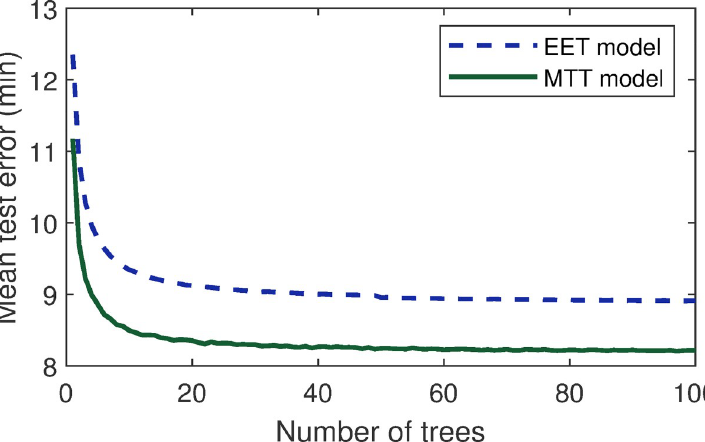
Fig 5. Random Forest regression (RFr) method performance with the estimated elapsed time (EET) and minimum turnaround time (MTT) models for a different number of trees.